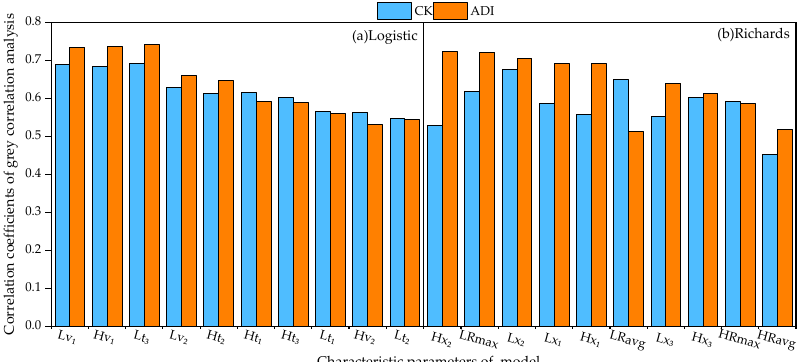
Figure 6. Grey correlation analysis of growth characteristic parameters and yield of tomato under irrigation method treatments. ( a ) is the growth characteristic parameters of Logistic model, and ( b ) is the growth characteristic parameters of Richards model.